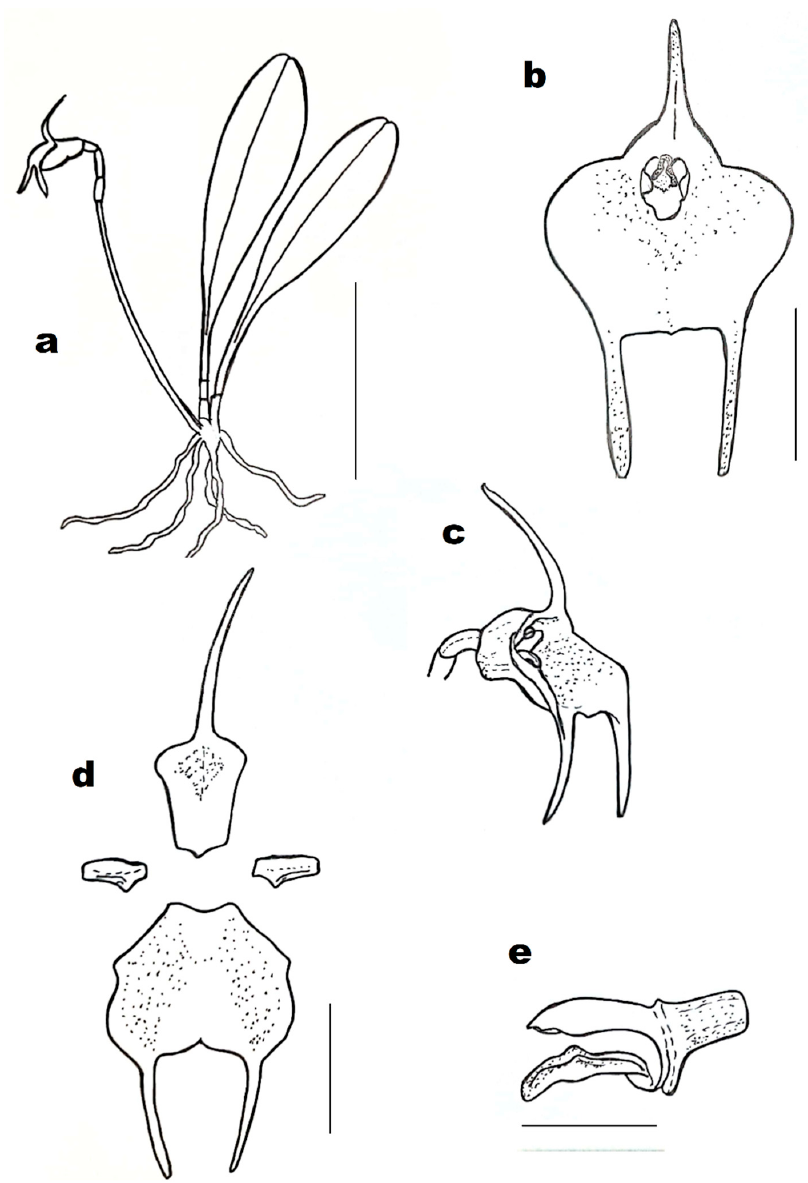
Figure 2. Masdevallia floribunda : ( a ) habit; ( b ) front view of the flower; ( c ) side view of the flower; ( d ) perianth parts; ( e ) side view on column and lip (redrawn by Lipi ń ska, scale bars: ( a ) 5 cm; ( b , d ) 1 cm; ( e ) 1 cm).